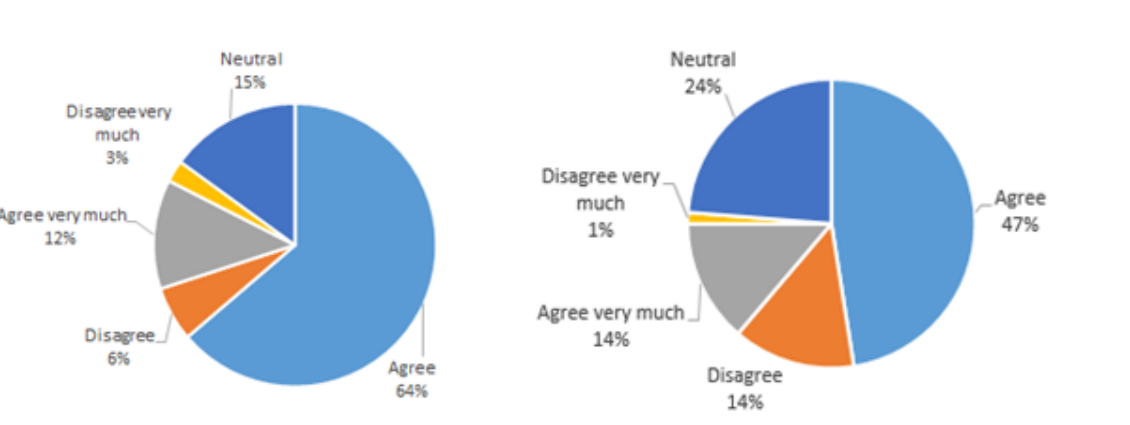
Figure 6. The methods of assessment for this subject are fair and